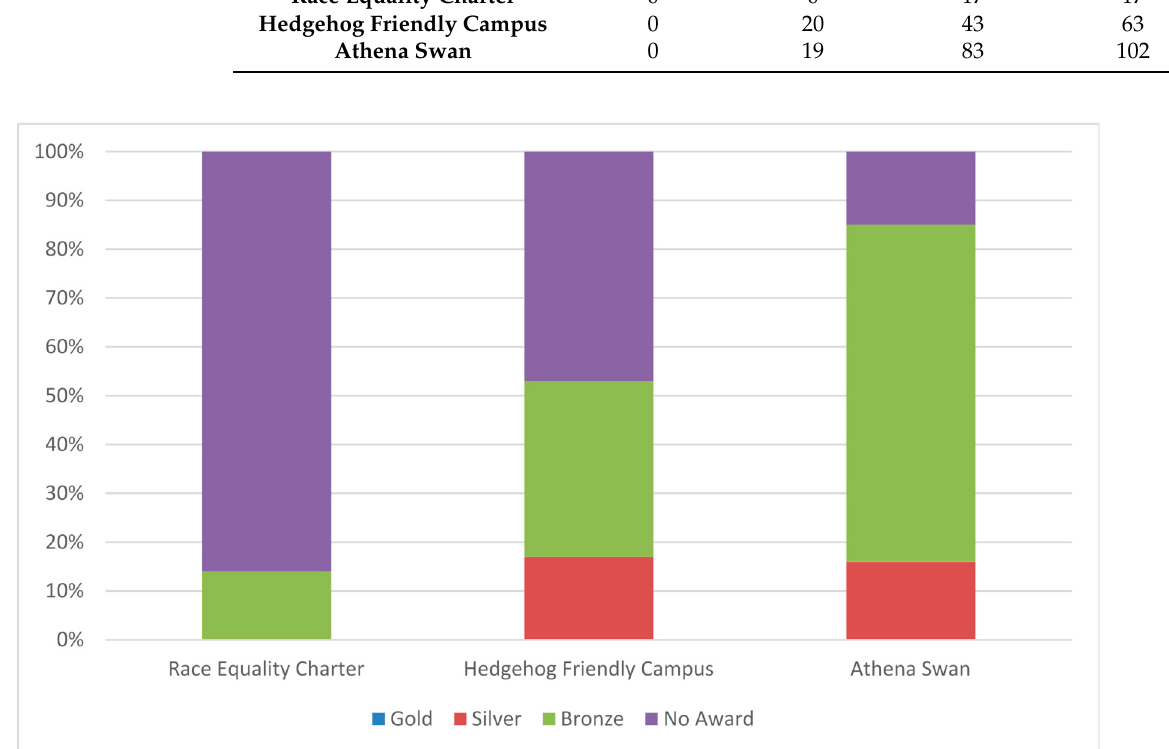
Figure 1. Percentage of UK universities with gold, silver or bronze awards from the Race Equality Charter, the Hedgehog Friendly Campus initiative, and Athena Swan.